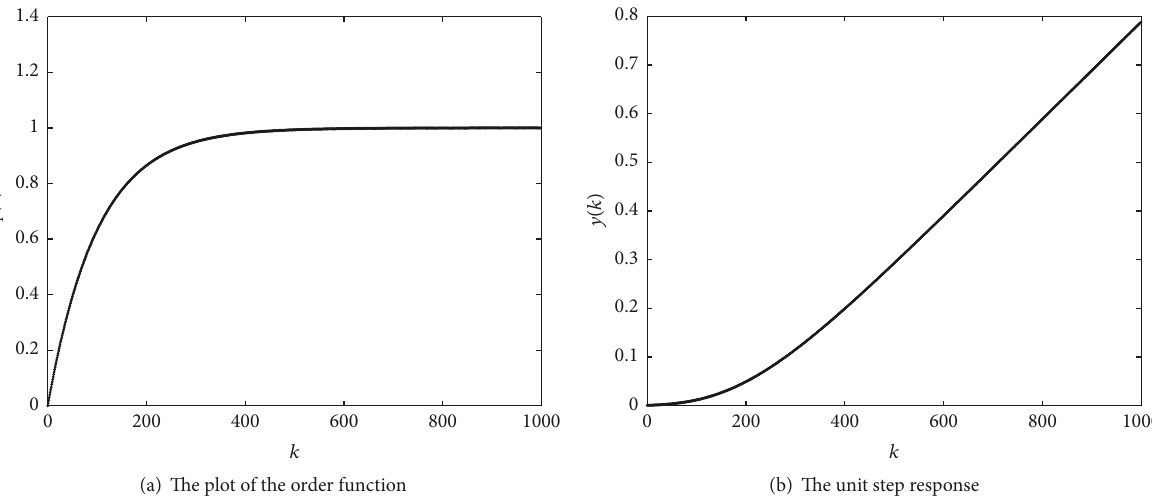
Figure 4: Image of the matrix and 3D plot of values of the matrix [ 𝑘